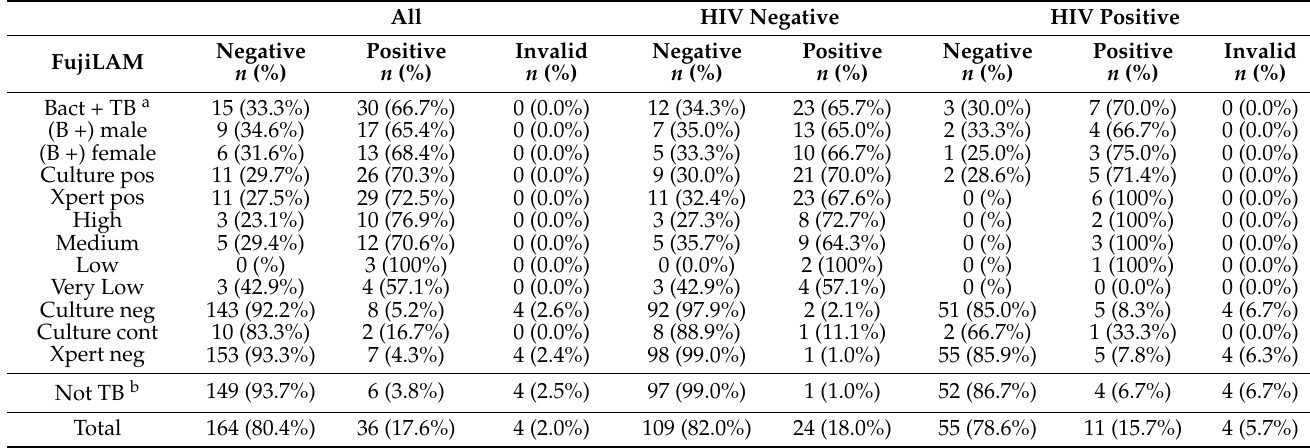
Table 2. FujiLAM test results by TB and HIV status.